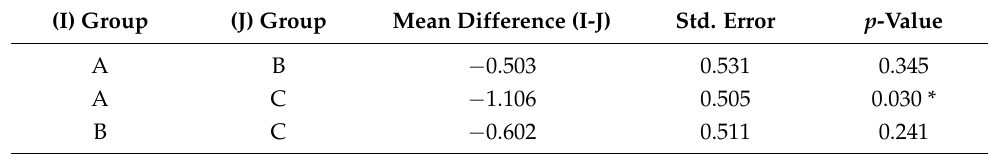
Table 3. Pairwise comparisons between groups of the post-test stage.